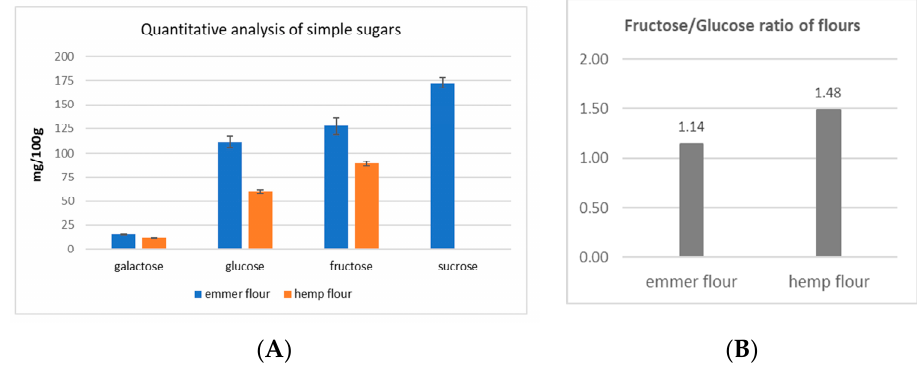
Figure 2. ( A ) Quantitative analysis of simple sugars in emmer and hemp flours (mg/100 g); ( B ) fructose/glucose ratio in emmer and hemp fl ours.